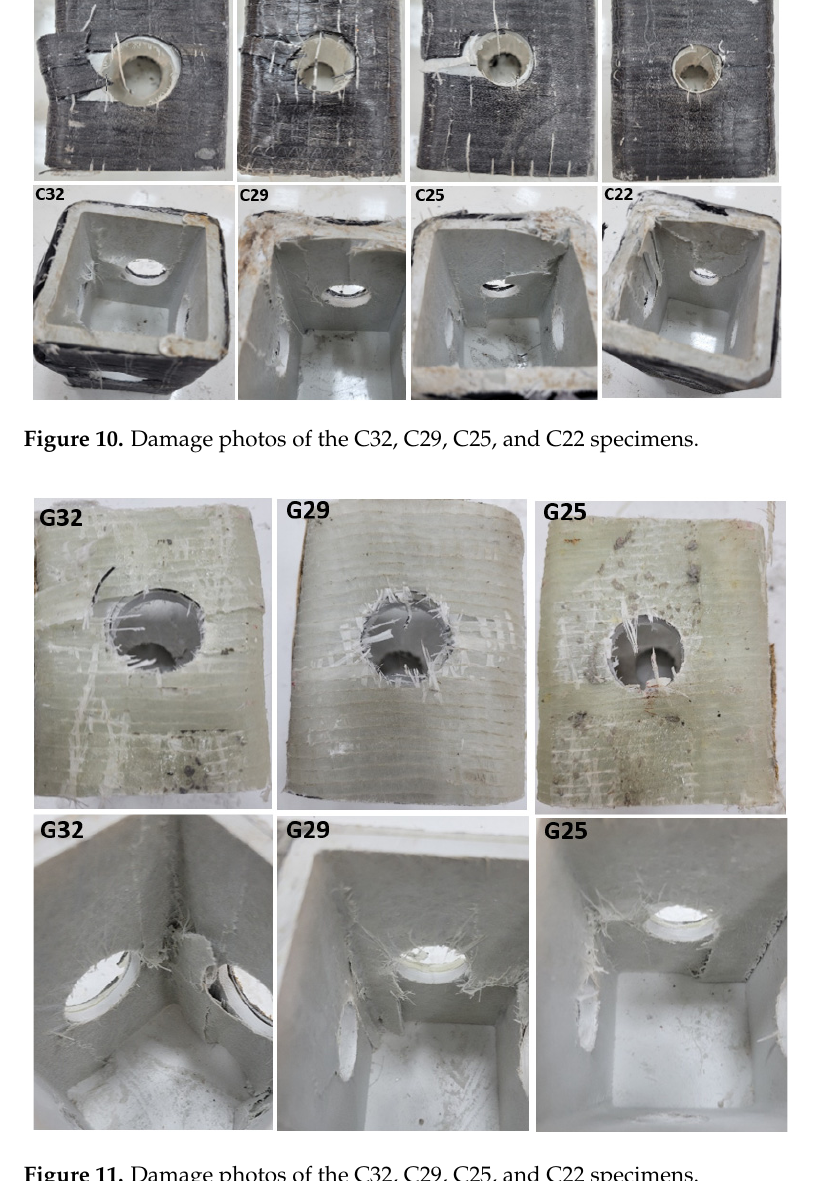
Figure 11. Damage photos of the C32, C29, C25, and C22 specimens.